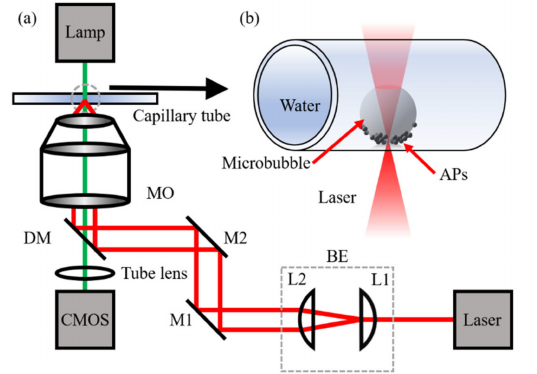
Figure 1. ( a ) Experimental setup. BE, beam expander; M1–M2, mirrors; DM, dichroic mirror; L1–L2, lenses; MO, microscope objective; CMOS, CMOS camera; ( b ) Schematic diagram of a microbubble in a capillary tube. The microbubble is generated by laser irradiation on APs. Some APs gather at the bubble